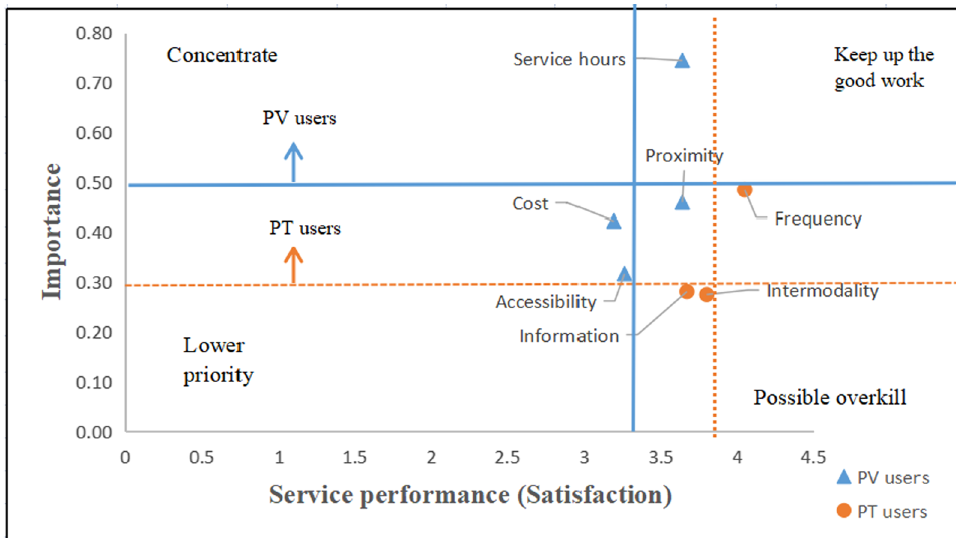
Fig. 3 Importance—satisfaction/performance results for the PV users (blue) and the PT users (orange) colored in the vertical and horizontal